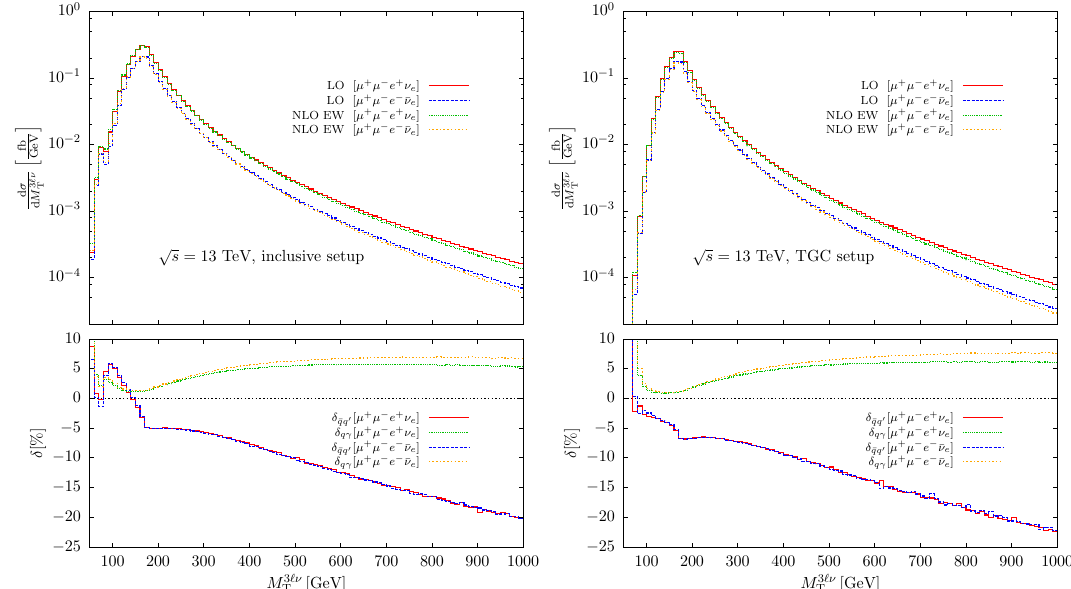
Figure 3 . Distribution in the transverse mass of the four-lepton system in the inclusive setup (left panel) and in the TGC setup (right